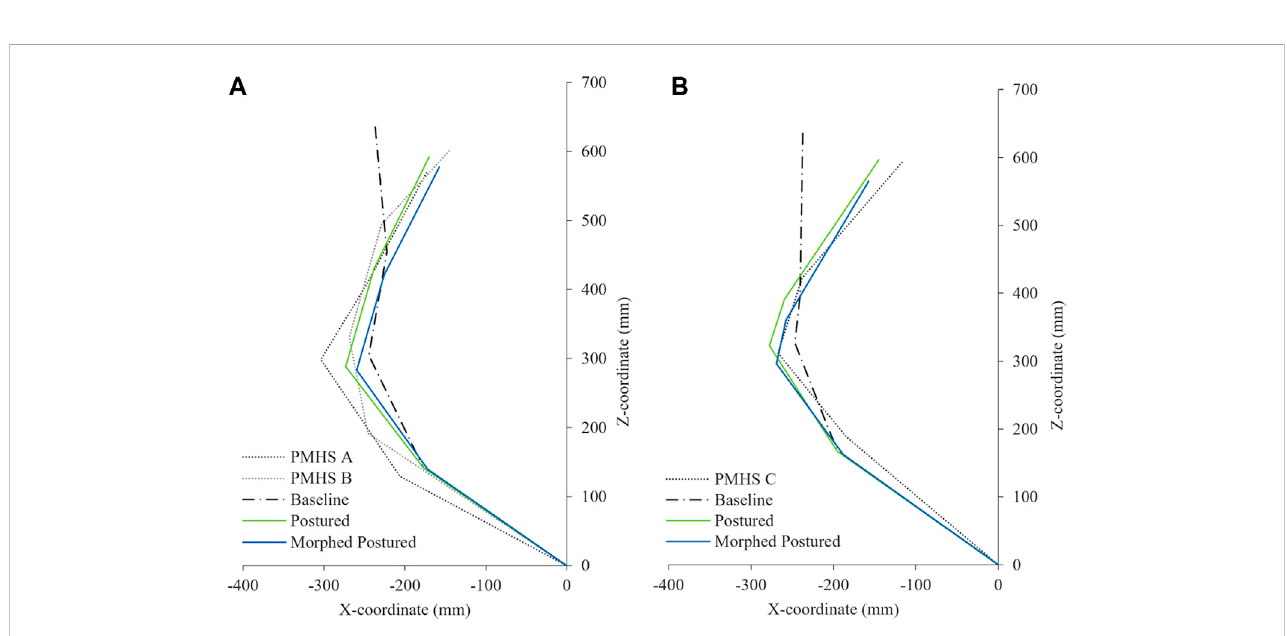
Fixed mass parts (skeleton, internal organs, etc.) (kg)